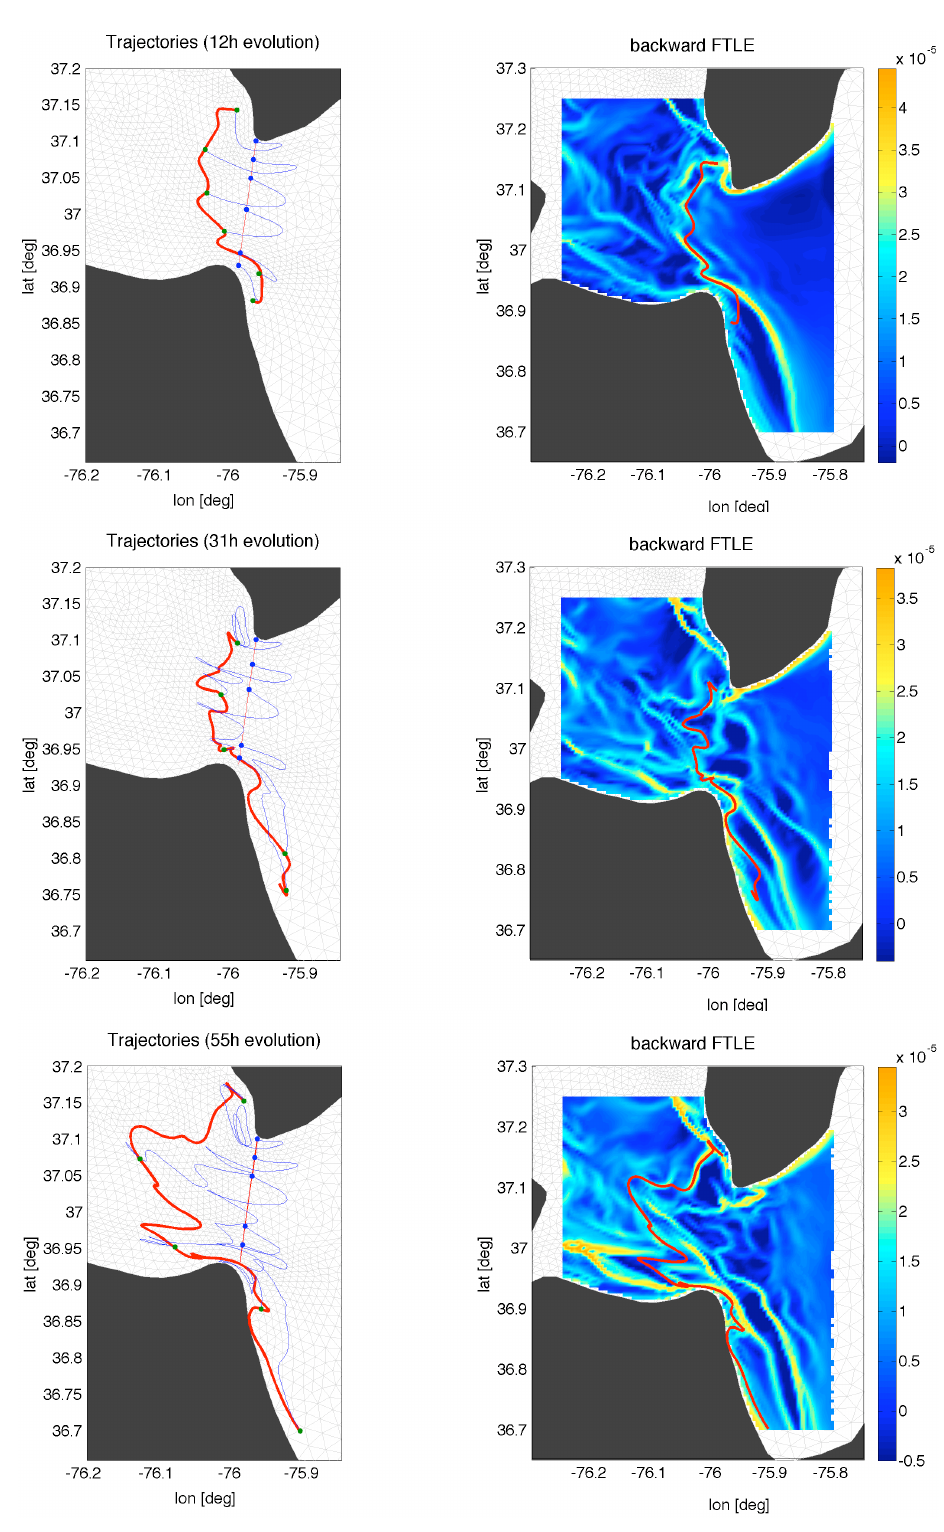
Fig. 7. Trajectories (blue, left column) and backward FTLE fields (right column) computed for a surface flow at the mouth of the Chesapeake Bay. The red curves denote the geometry of material segments evolving in the flow from the straight line ‘blocking’ the mouth after 12h (first row), 31h (middle row), and 55h (bottom row). Note that the material segments shown develop a series of bulges along the western shore which are reminiscent of the freshwater outflow plume. In this flow, the location and connectivity of the ridges in the FTLE fields are sensitive to the integration time T (see also §3 and Branicki and Wiggins (2010))